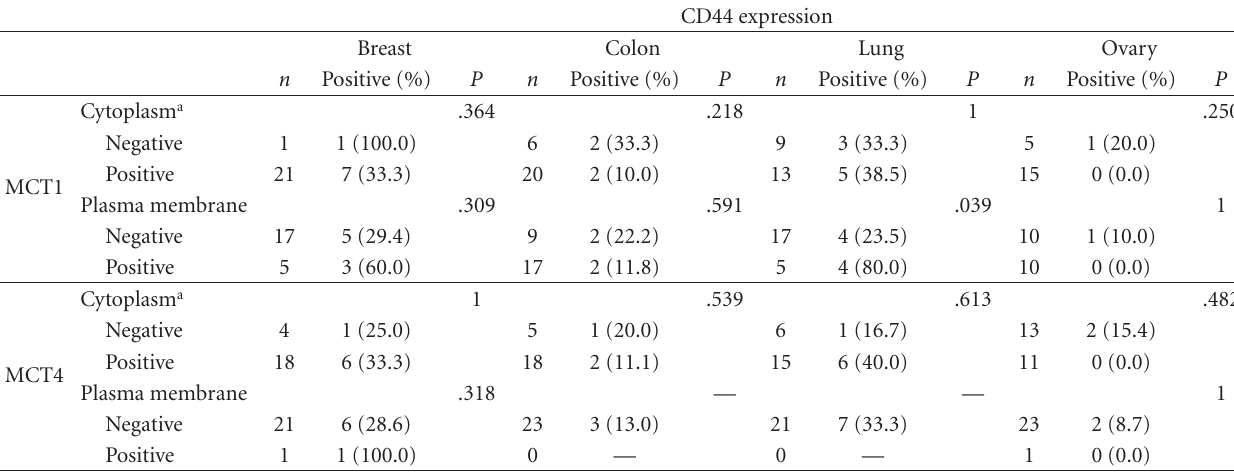
Table 4: Correlations between MCTs and CD44 expressions in